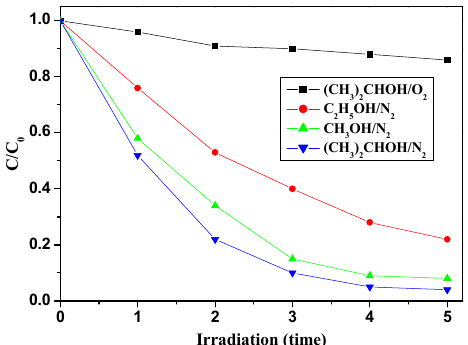
Figure 8. Effect of hole trapping agent on the photoreductive degradation of BDE209 by g-C 3 N 4 -TiO 2 under visible light irradiation. BDE209: 1.0 × 10 − 5 mol/L; 0.02-g-C 3 N 4 -TiO 2 : 1 mg/1 mL; wavelength >420 nm; solvent: CH 3 CN; trapping agents: isopropanol, methanol, ethanol 0.1 mL.